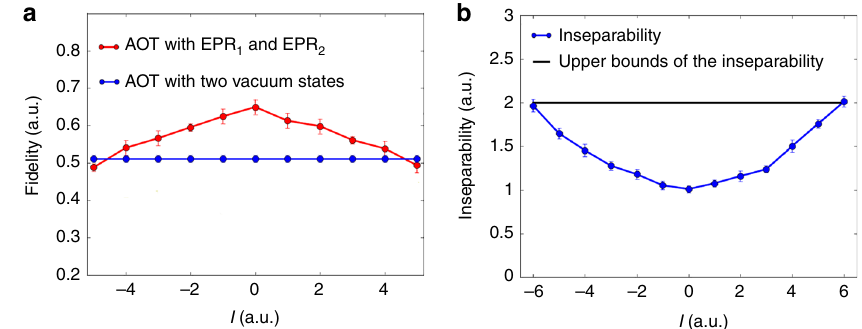
Fig. 4 Fidelity of all-optical teleportation versus the topological charge of the input modes. a The fi delity of all-optical teleportation (AOT) for teleporting different orbital angular momentum (OAM) modes. The red dot trace indicates the fi delity of AOT with the help of EPR 1 and EPR 2 . The blue dot trace indicates the fi delity of AOT with only two vacuum states. b The inseparability of the OAM multiplexed entanglement source versus topological charge ℓ (the blue dot trace). The black straight line denotes the upper bound of the inseparability. The error bars are obtained from the standard deviations of multiple